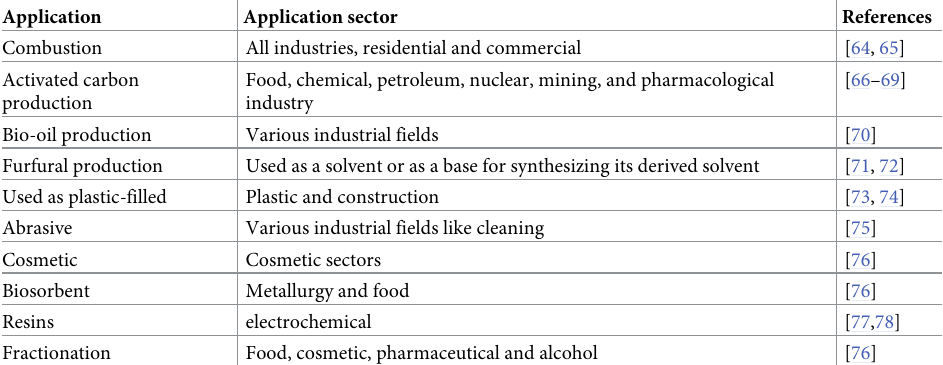
Table 4. Various applications of olive stone and their application